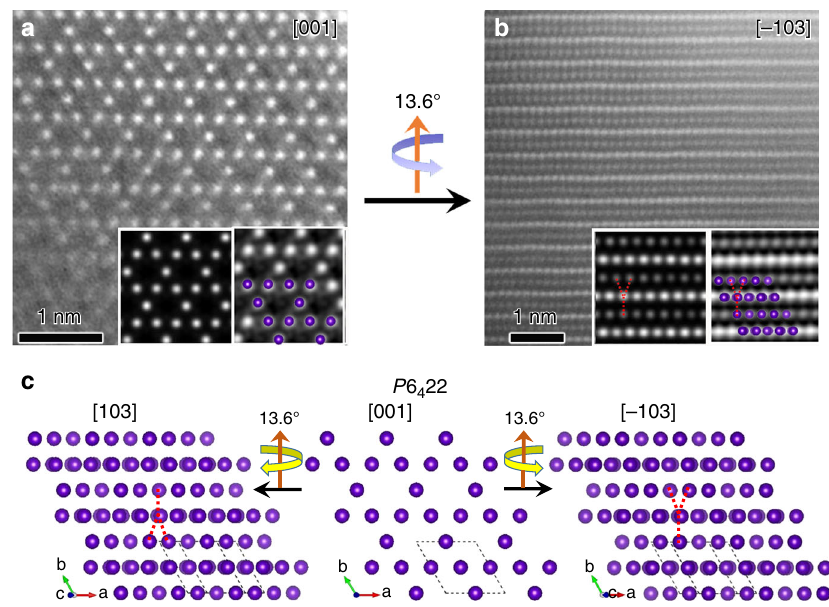
Fig. 4 Handedness determination of one TaSi2 crystal. STEM-ADF images of a tantalum silicide crystal along the a [001] and b [ − 103] zone axes (insets are simulated (left) and p 1 symmetry-averaged images (right) overlaid with structural models; purple spheres represent Ta atoms, Si atoms are omitted for clarity). c Projections of TaSi 2 crystal structural models with left-handedness along different orientations in a tilt